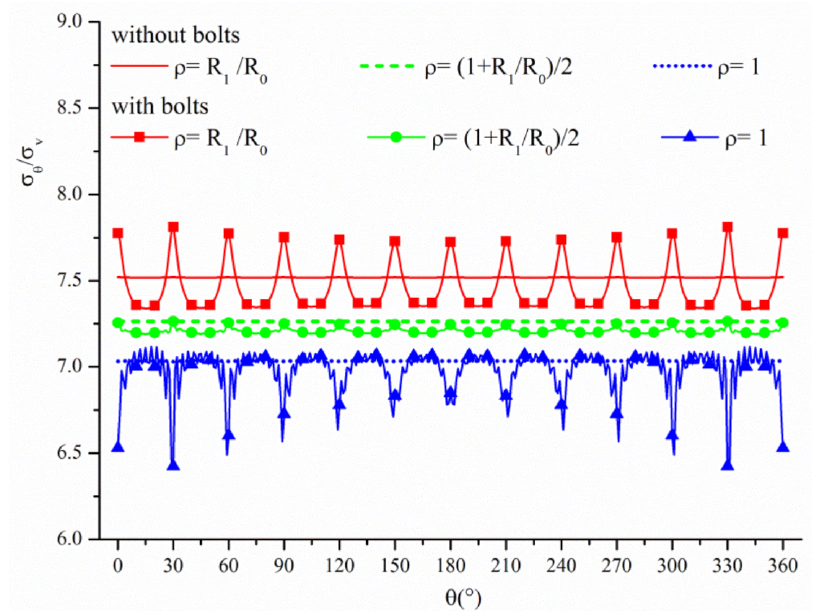
Figure 7. The effect of bolts on the tangential stress of the lining.